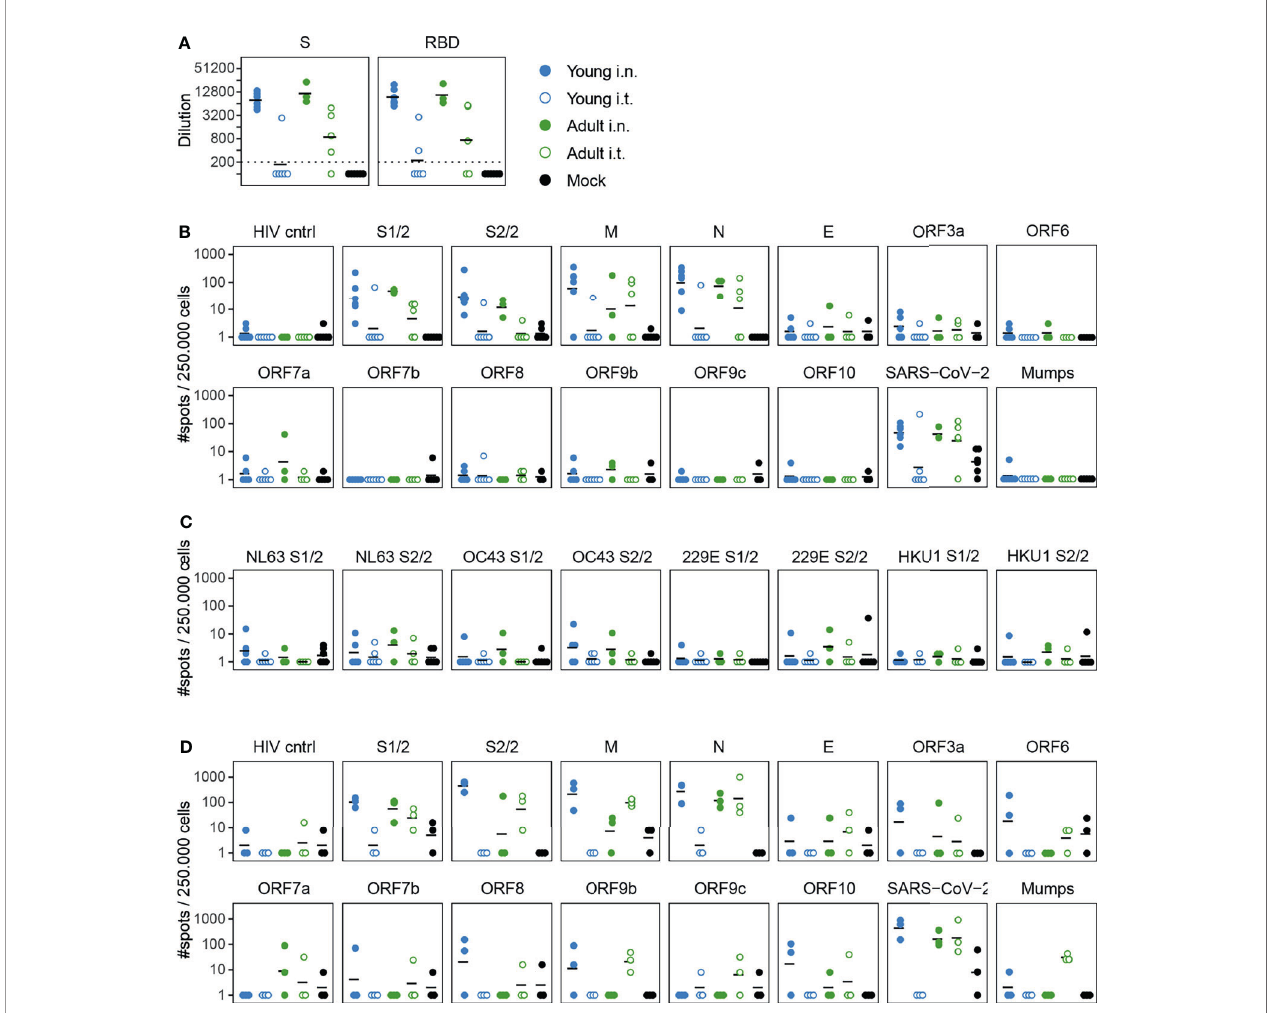
FIGURE 5 | Cellular and humoral responses in SARS-CoV-2 infected ferrets are affected by inoculation route. (A) Humoral responses detected by ELISA against whole spike (S) and the receptor binding domain (RBD) region of spike in serum 14 dpi. Responses are depicted as the (modelled) dilution at which the ELISA curve drops below background (mean + 3x SD of SARS-CoV-2 naïve animals at 200x dilution). The dotted line indicates the lowest dilution tested and negative samples were set to half that dilution for visualization purposes. (B – D) Cellular responses in PBMCs (B, C) and lung-derived lymphocytes (D) as determined by IFN g -ELISpot. Cells were stimulated with SARS-CoV-2 peptide pools or live virus. HIV cntrl and Mumps are negative controls for peptide pool and virus stimulations respectively. Data shown here were corrected for medium background and were set to a minimum of 1 spot for visualization on a log-scale. (B) PBMCs isolated 14 or 15 days post infection (dpi). (C) Frozen PBMCs isolated 14 or 21 dpi were thawed and stimulated with peptide pools of endemic human coronaviruses. (D) Responses by lung-derived lymphocytes at 21 dpi. For b and c, samples were collected 14 and 15 or 14 and 21 dpi respectively, but visualized as a single group. N = 3-6 for panels (A – C) and n = 3 for panel (D) . Black lines indicate (geometric) mean per